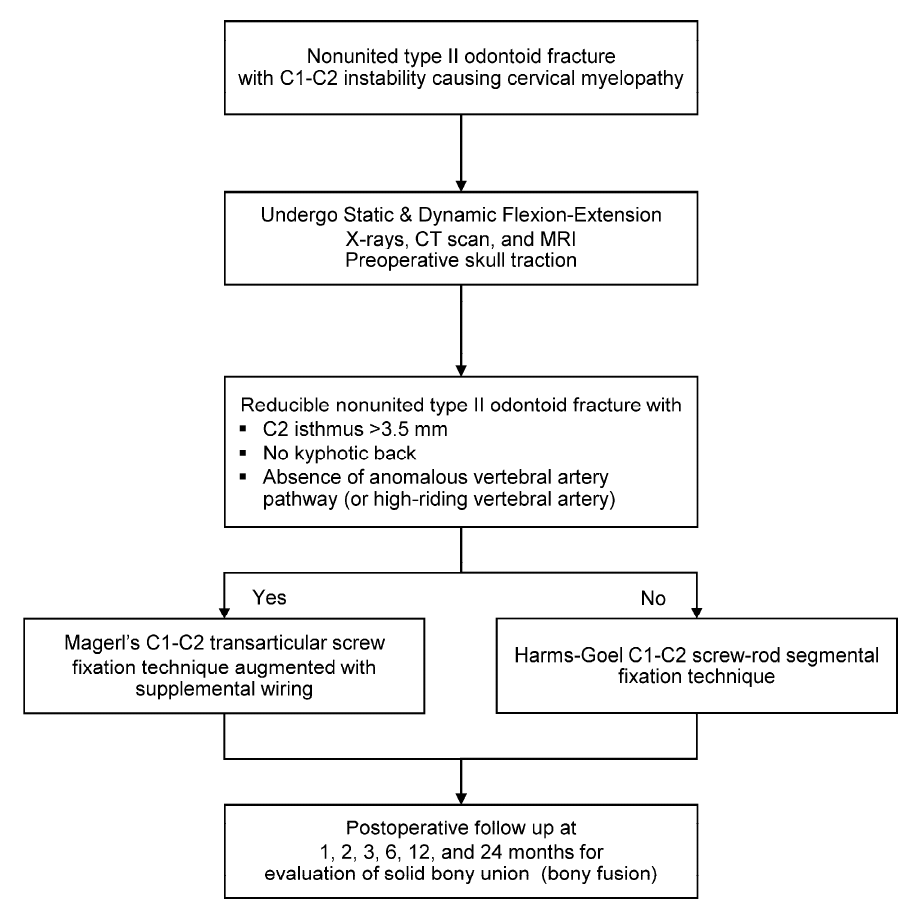
Figure 2. Patient management protocol at Chiang Mai University Hospital.